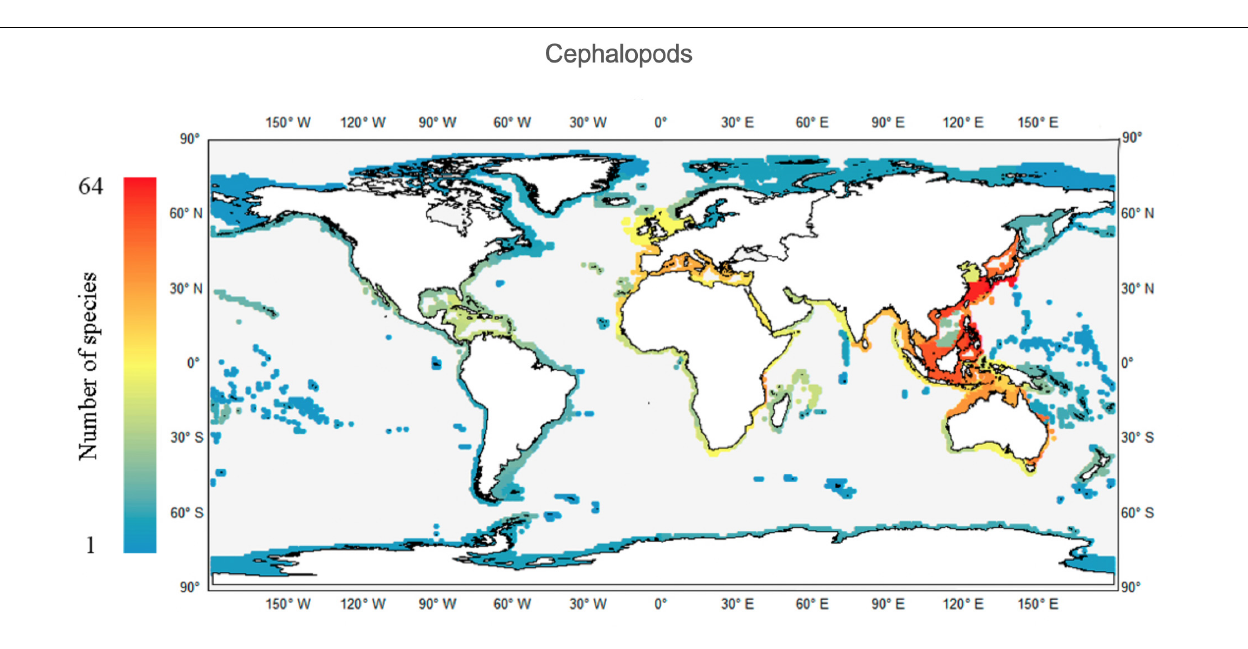
FIGURE 4 | Worldwide richness (number of species per ecoregion) patterns of coastal